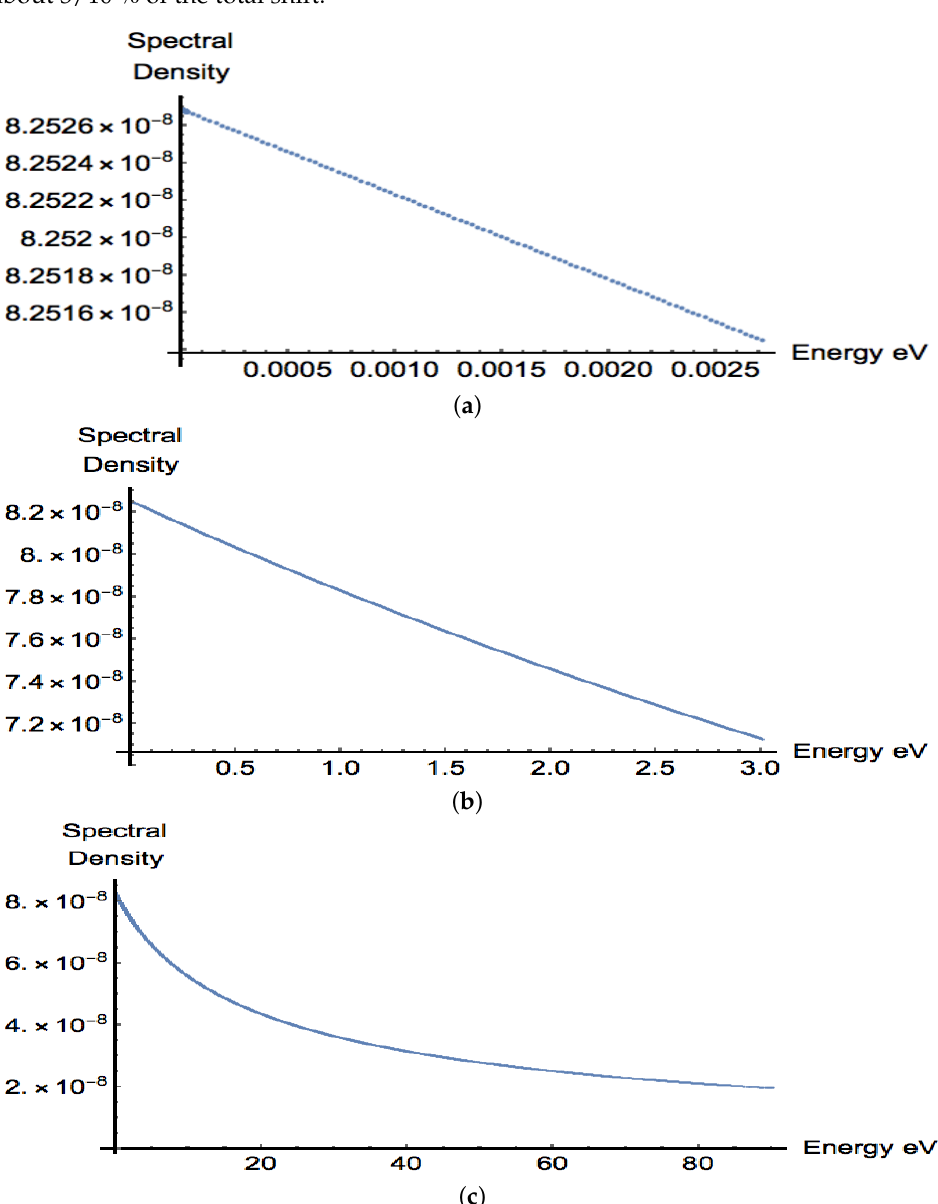
Figure 3. Linear plots of the ground state spectral density calculated from group theory as a function of energy for low and mid energies. From about 10 eV to 0 eV, the spectral density increases linearly to its maximum value. The value of the abscissa at the origin is 0 eV for all graphs. ( a ): Linear change in ground state spectral density at very low energies. ( b ): Near linear change in ground state spectral density for visible and near infra-red energies. The contribution to the total shift for energies below 3 eV is about 0.7%. ( c ): Ground state spectral density calculated for energies below 80 eV, which contribute about 8.6% to the total